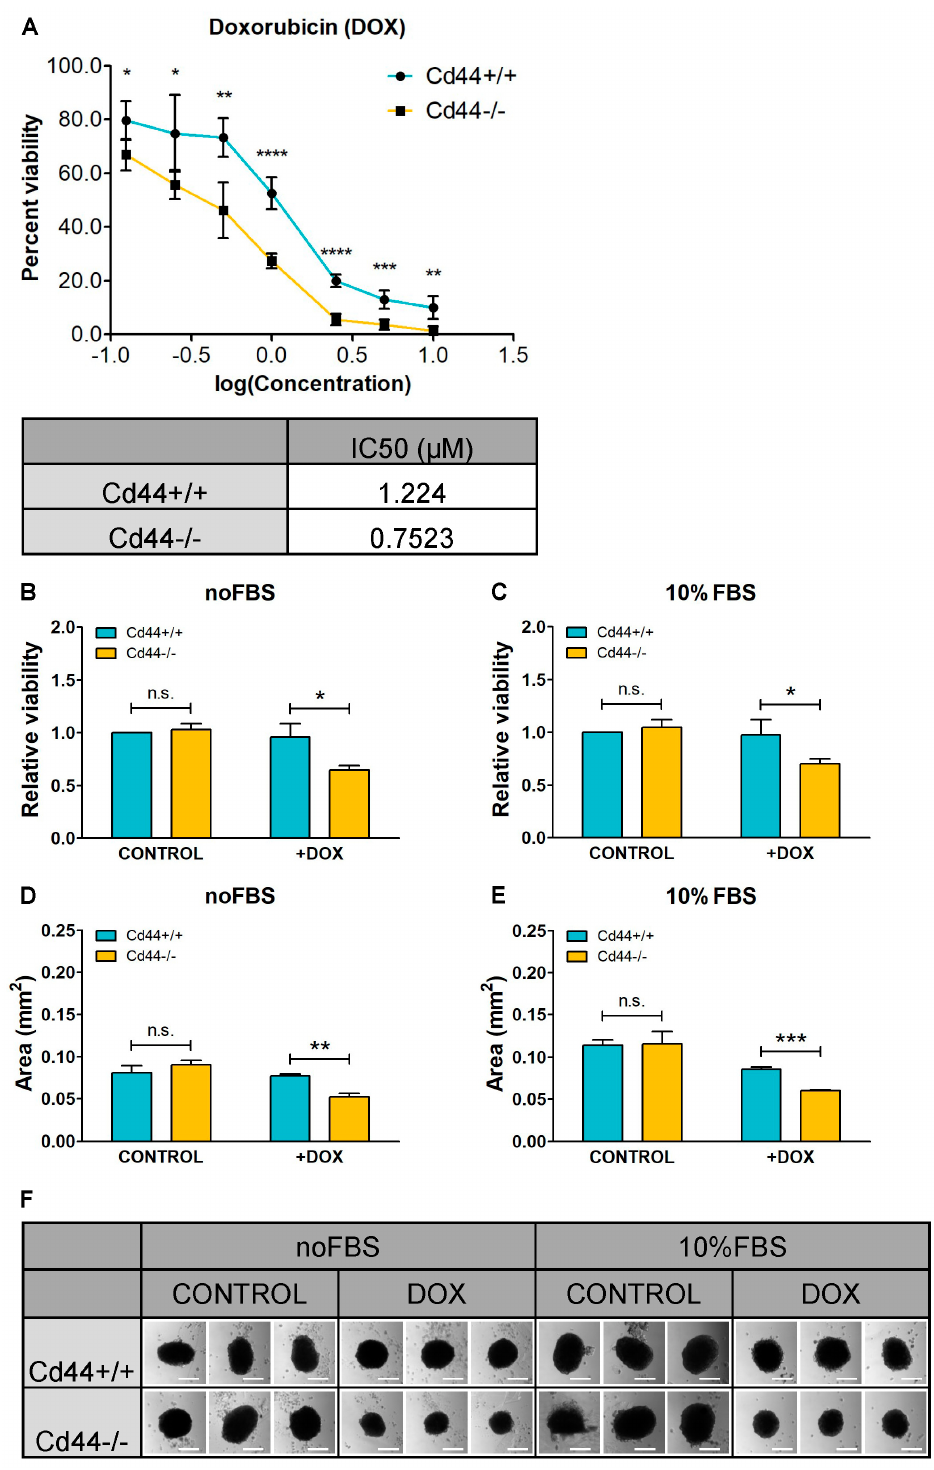
Figure 1. Knockout of Cd44 sensitizes osteosarcoma cells to doxorubicin (DOX) treatment. ( A ) Determination of the half-maximal (50%) inhibitory concentration (IC50) of DOX. Dose-response curve of Cd44 -positive and Cd44 -negative osteosarcoma cells to DOX (upper panel) and corresponding IC50 values (lower panel) are shown. Cell viability was measured in quintuplicates in five independent experiments using WST1 assay. IC50 was calculated using GraphPad Prism and nonlinear regression. ( B , F ) Influence of DOX on formation of Cd44 -positive and Cd44 -negative spherical colonies. The histograms represent relative mean values of cell viability ( B , C ) or surface area ( D , E ) ±SD from three independent colony formation assays. Representative pictures of colo- nies formed in the presence or absence of DOX, either upon serum starvation or in medium sup-